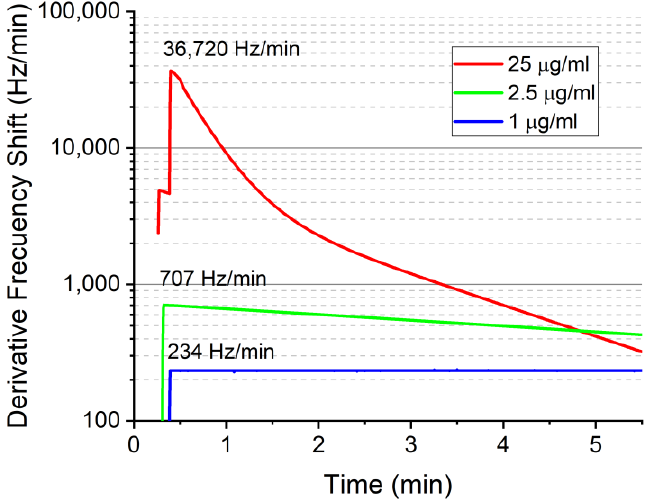
Figure 7. Fitted responses for the three concentrations of FGF-2 detected.